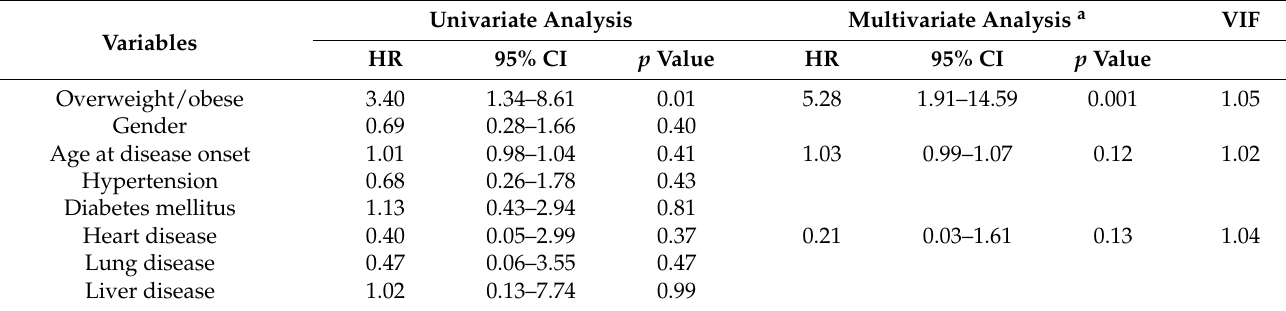
Figure 2. HSK recurrences: ( A ) overall recurrence rates; ( B ) 12-month recurrence rates; ( C ) 18-month recurrence rates. Table 2. Cox Regression Analysis of Variables Associated with Overall Recurrence.